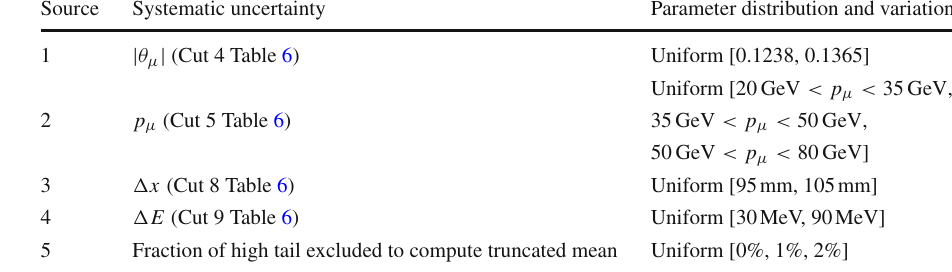
of the parameters are reported